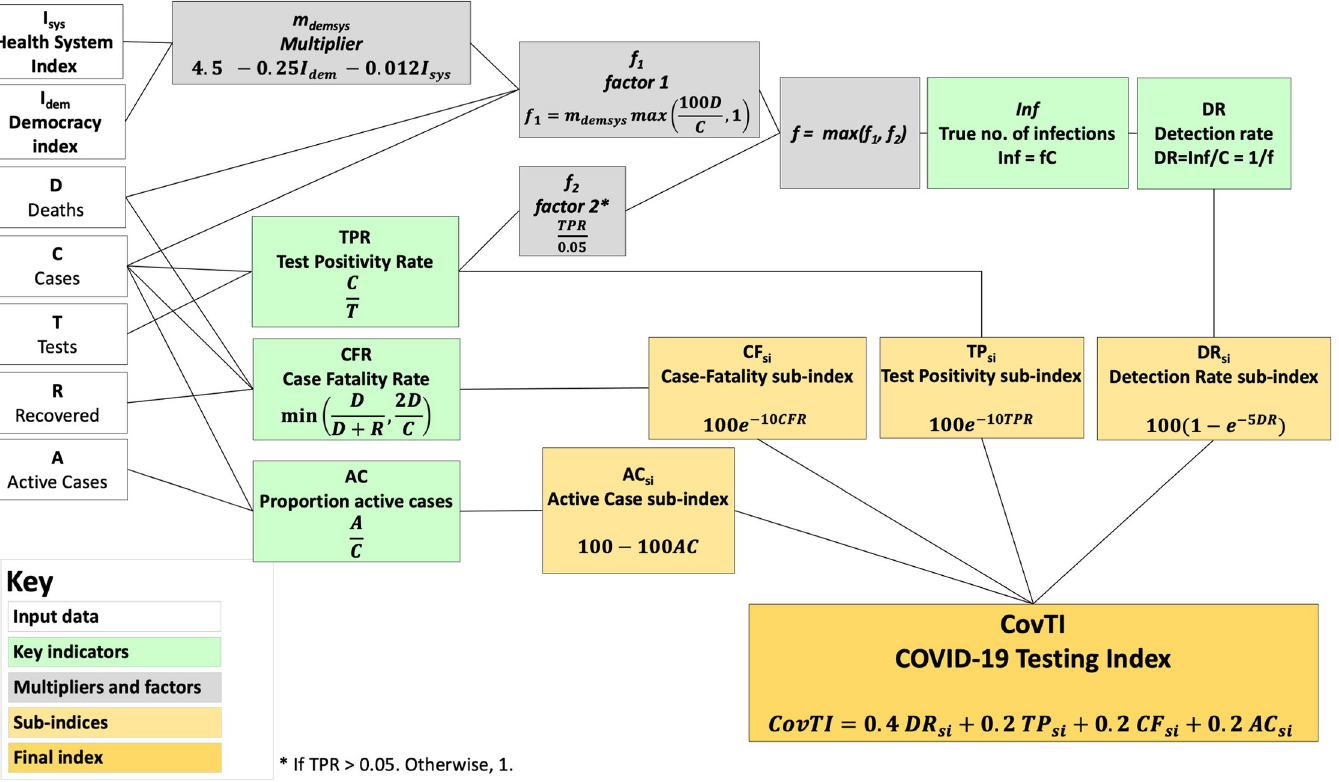
Fig 1. Schematic diagram illustrating method to compute the COVID-19 Testing Index (CovTI). The CovTI was computed from a weighted sum of the four sub- indices (orange), each of which is derived from one key indicator (green). The input data for each indicator (white) and intermediate steps (grey) are shown.